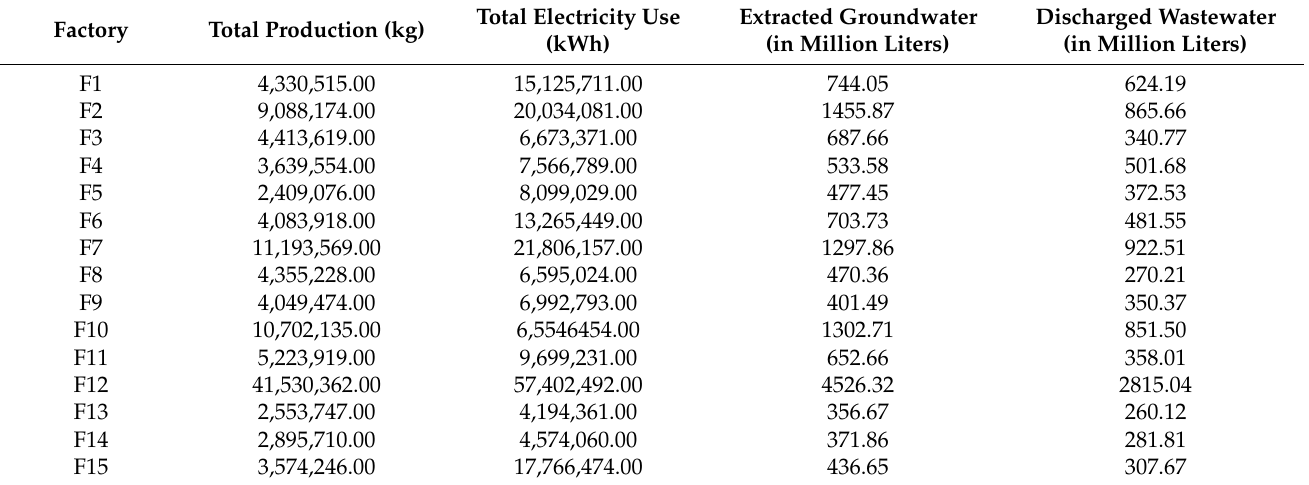
Table 1. Resource Consumption Data Collected from 15 Textile Dyeing